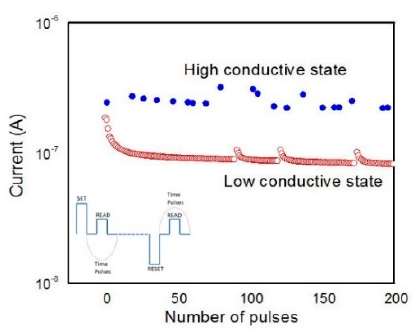
Figure 5. Memory retention time of PEDOT:PSS based memory cells (inserted picture depicts the pulsing sequences utilized for retention time test).